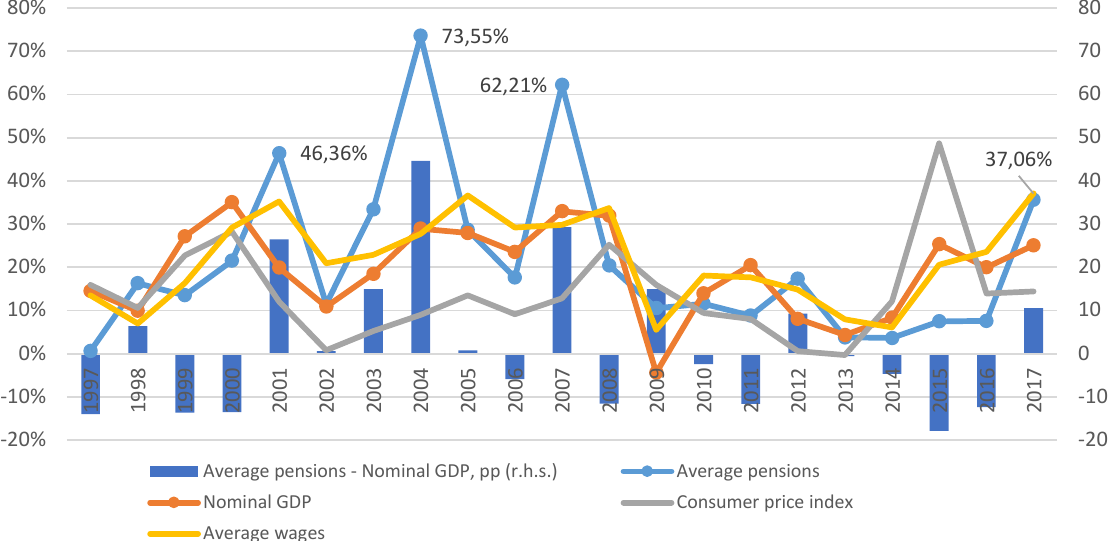
Figure 1. The growth rate of some macroeconomic indicators in Ukraine in 1997–2017